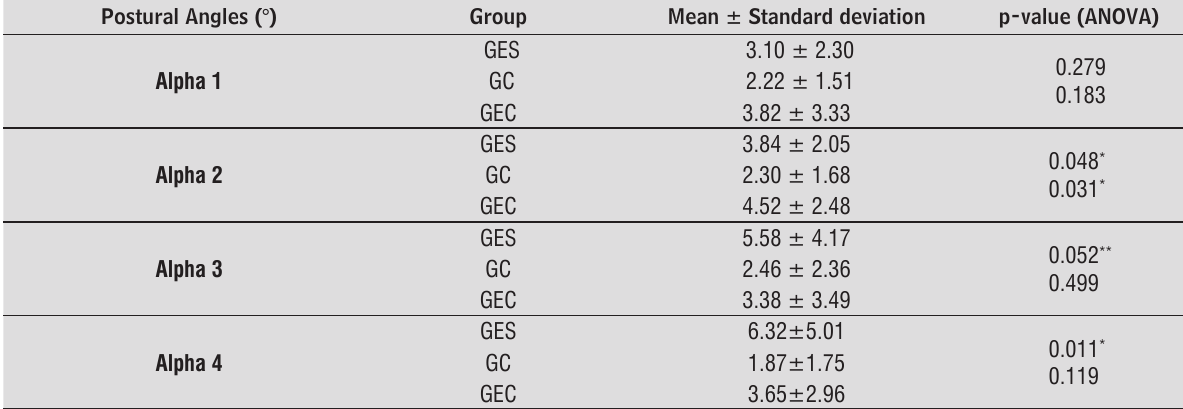
Table 1 - Analyses of postural angles of the control and experimental "S" groups and the control and experimental "C" groups in the static condition without shim